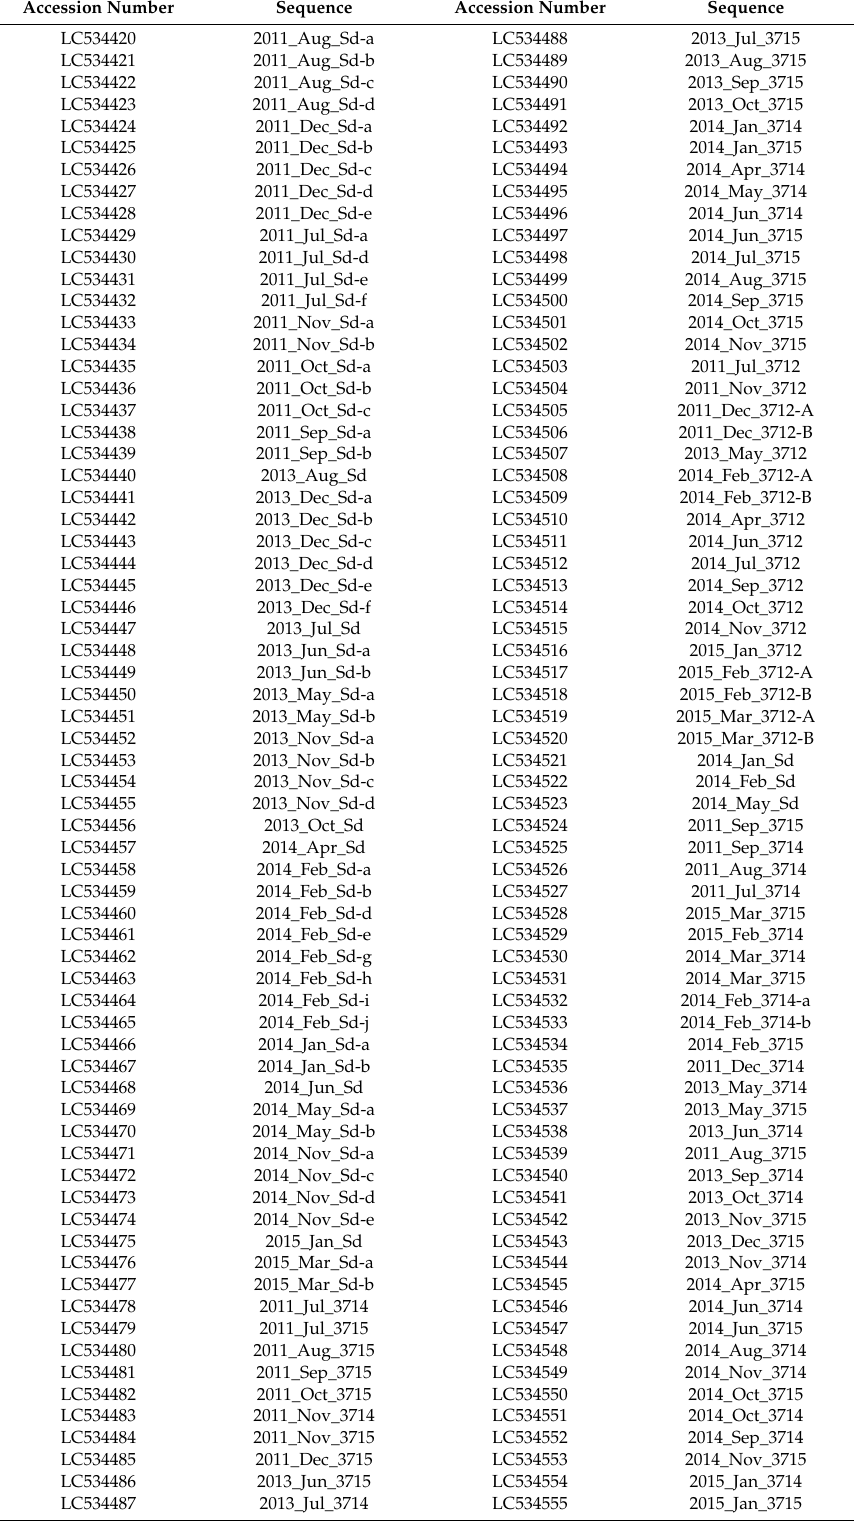
Table A1. List of accession numbers of the sequences determined in this